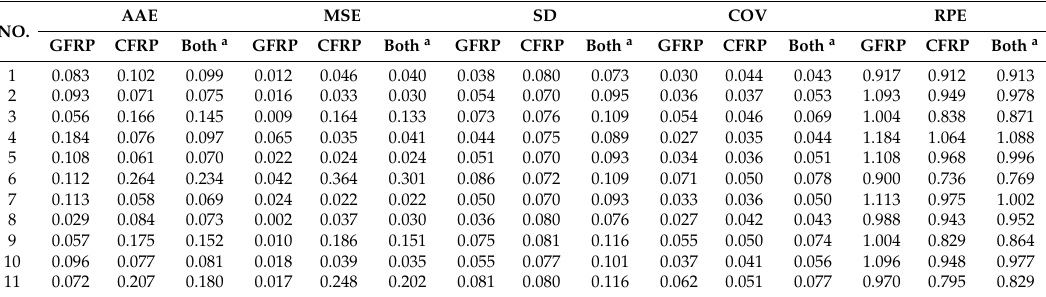
Table 10. Statistical assessment of the ultimate strain